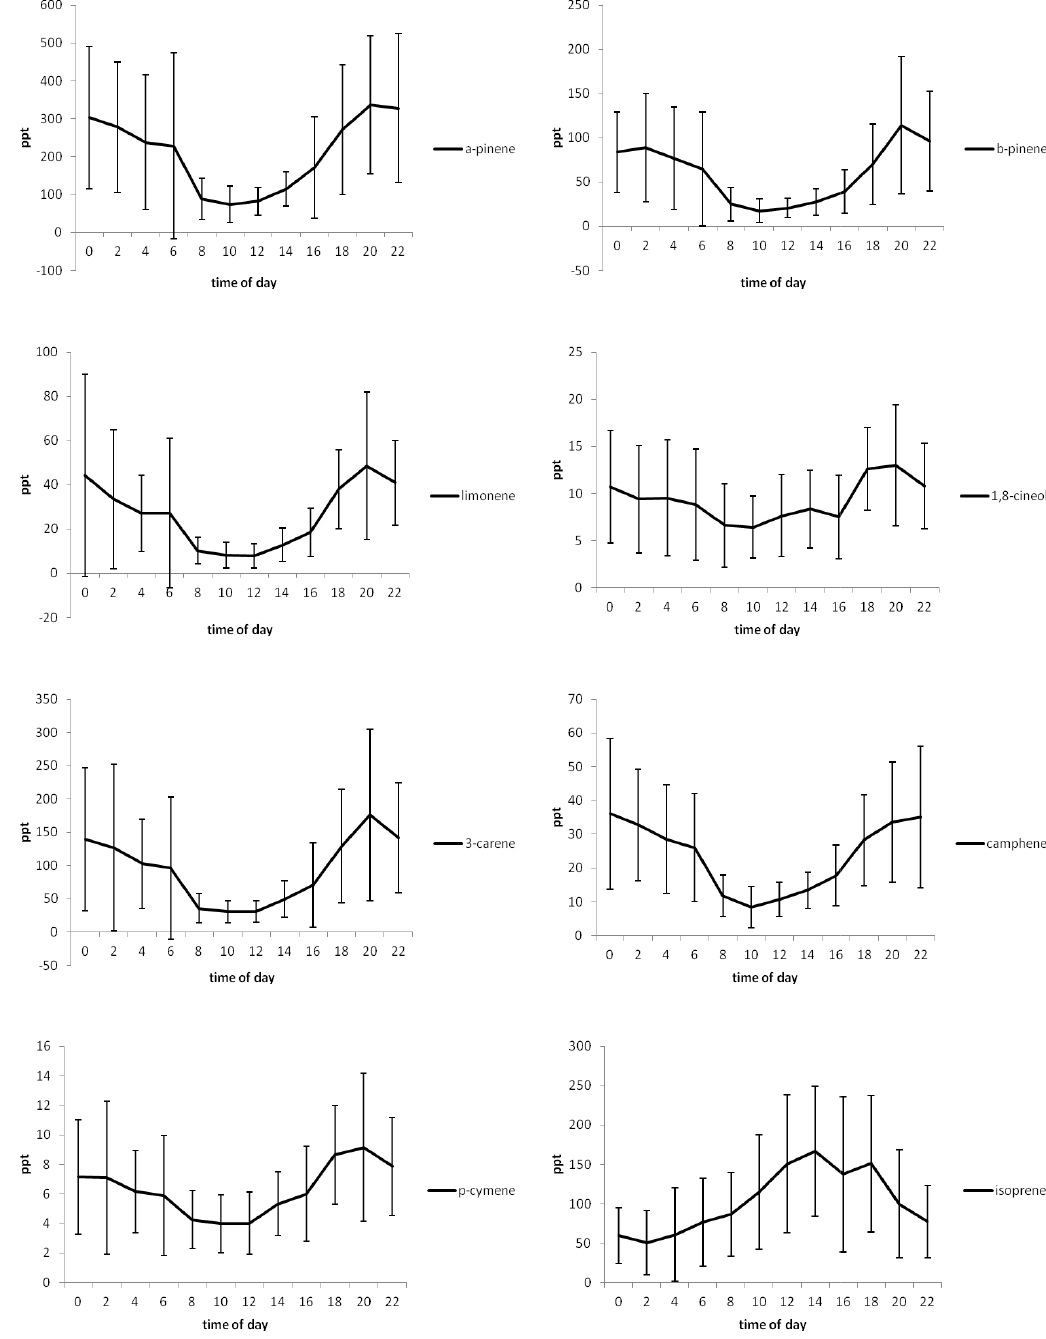
Fig. 8. The mean diurnal variability and standard deviations of monoterpenes and isoprene in summer (June, July, August). (Isoprene mixing ratios are underestimates due to breakthrough of the cold